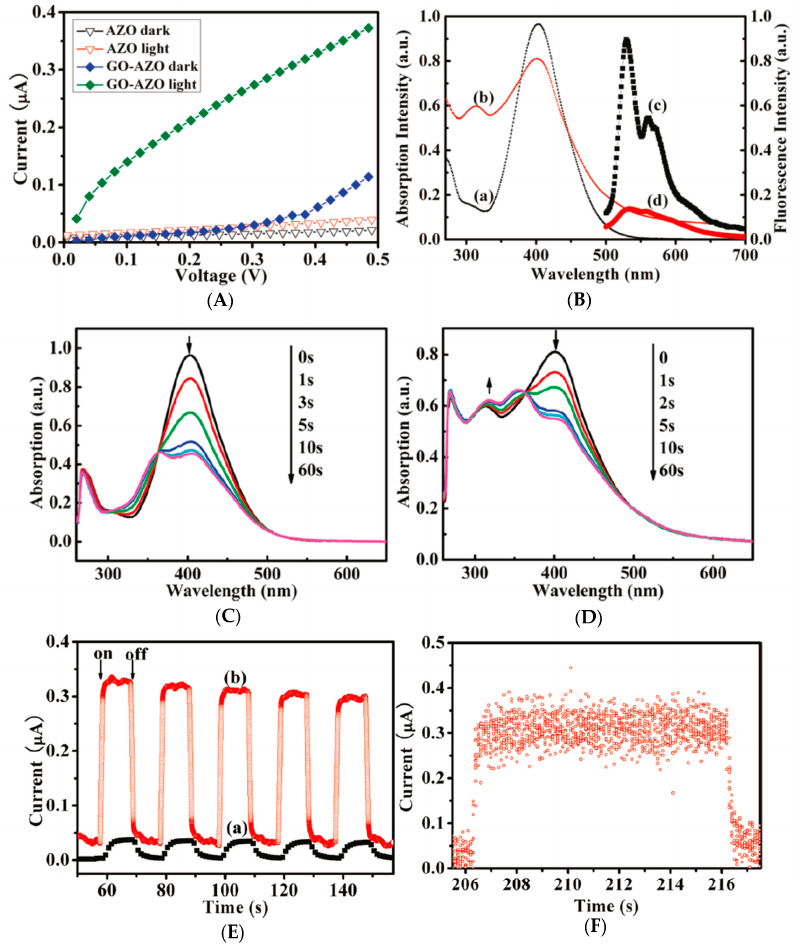
Figure 11. ( A ) Typical I-V characteristics of the GO-AZO and pristine AZO without and with UV irradiation (365 nm and 2.45 mWcm − 2 ). ( B ) Absorption spectra of ( a ) AZO and ( b ) GO-AZO, and the corresponding fluorescence spectra of ( c ) AZO and ( d ) GO-AZO in anhydrous dimethyl formamide (DMF) at 480 nm. ( C ) Changes in the absorption spectra of AZO and ( D ) GO-AZO in DMF at 365 nm. Arrows refer to the variations due to irradiation. ( E ) Photocurrent response of ( a ) pristine AZO and ( b ) GO-AZO films in 0.1 M KCl aqueous solution at 0.5 V bias, and ( F ) GO-AZO photocurrent responses in single on/off cycles